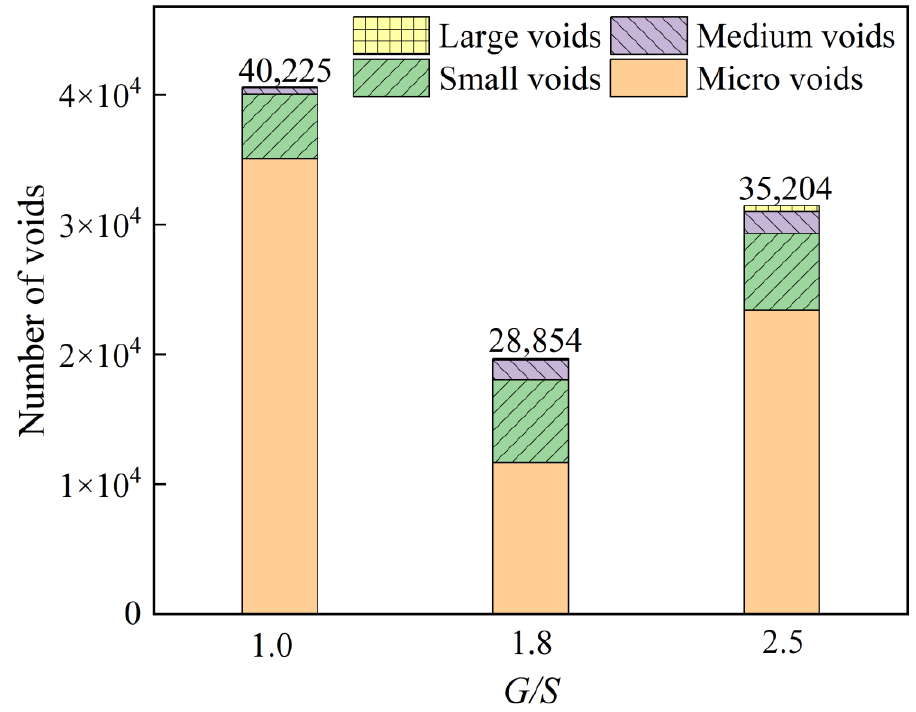
Figure 16. The number of voids of varying volumes counted for UPAB specimens with different G/S levels compacted by plate vibratory compaction.